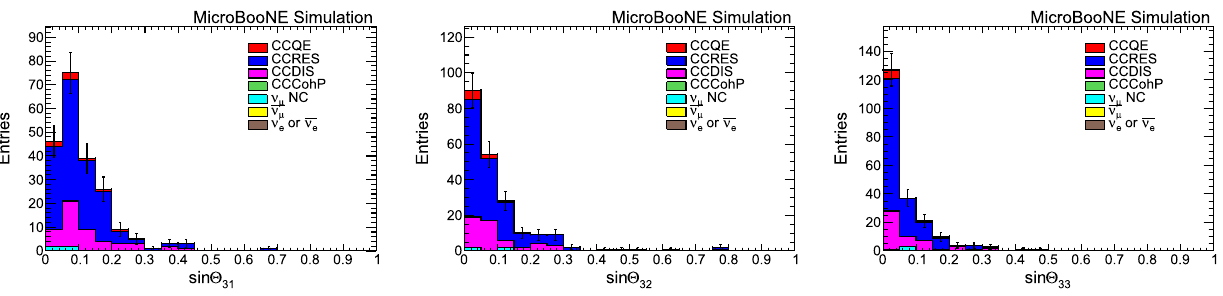
Fig. 36 Multiplicity = 3 Sin (cid:17) distribution for candidate muon (left); for second longest track (middle); for shortest track (right) from GENIE default MC. Black error bars represent MC statistical